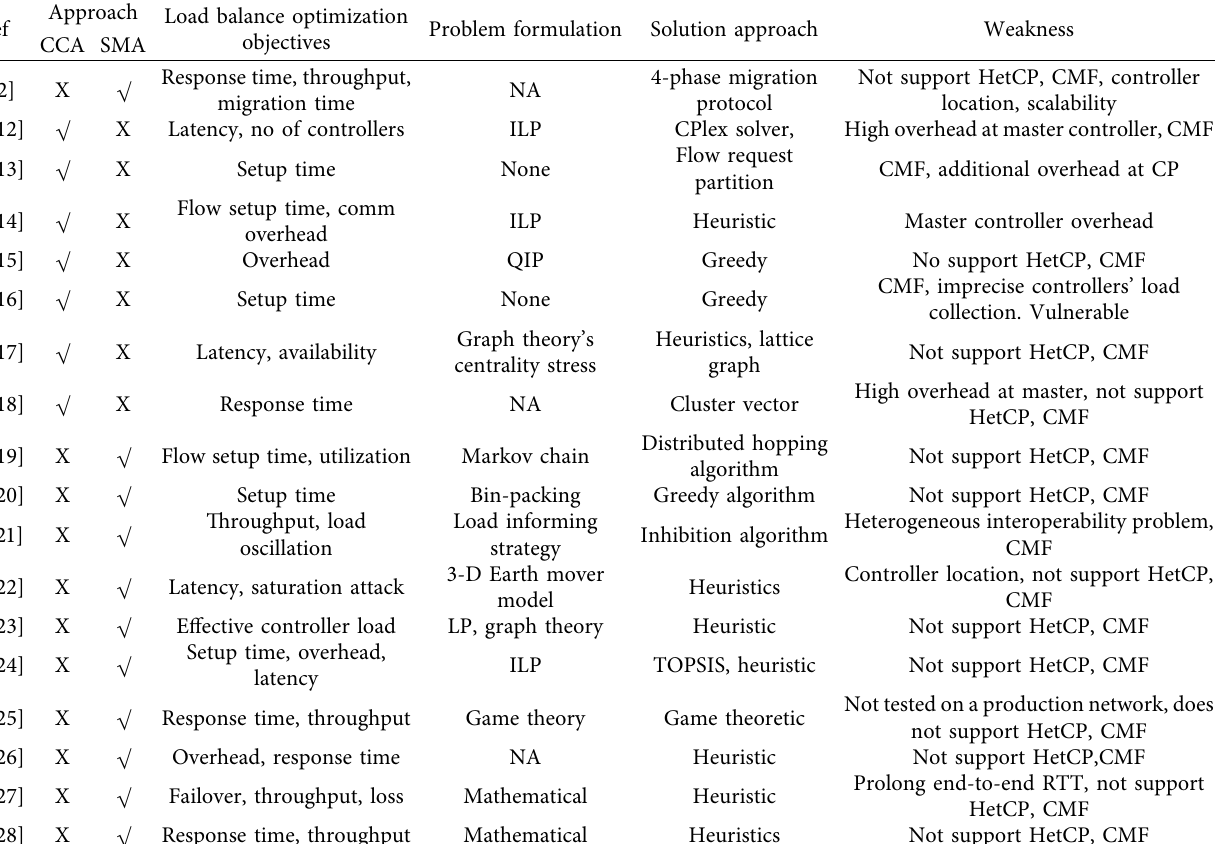
Table 8: Comparison of controller placement with load balance